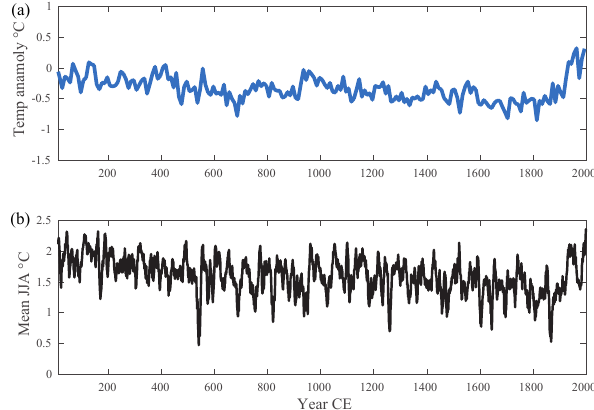
Figure 6. (a) Simulated decadal 2m air temperature ( ◦ C) during JJA spanning the terrestrial region of the Atlantic Arctic (60–90 ◦ N, 90 ◦ W–60 ◦ E) using the Community Earth System Model (CESM). Overall, the CESM-modeled temperature shows similar coolings to the glacier model results presented here. (b) Reconstructed Arctic- wide late Holocene temperatures (relative to the 1961–1990 in- strumental mean; Kaufman et al., 2009) showing similar structure and magnitude of change to the CESM simulation and our glacier